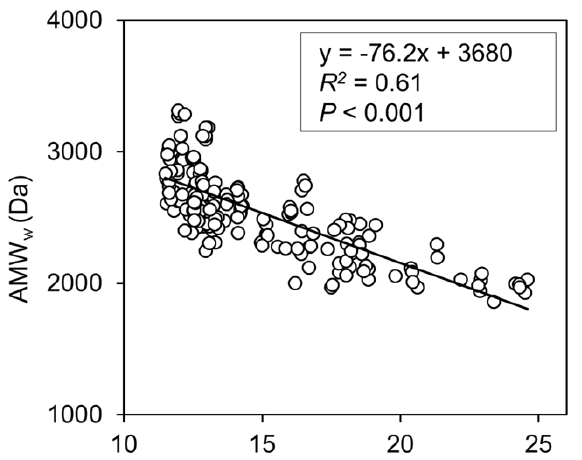
Fig. 6. Regression of AMW w versus slope coefficient S 275 − 295 of pooled experiment data ( n =